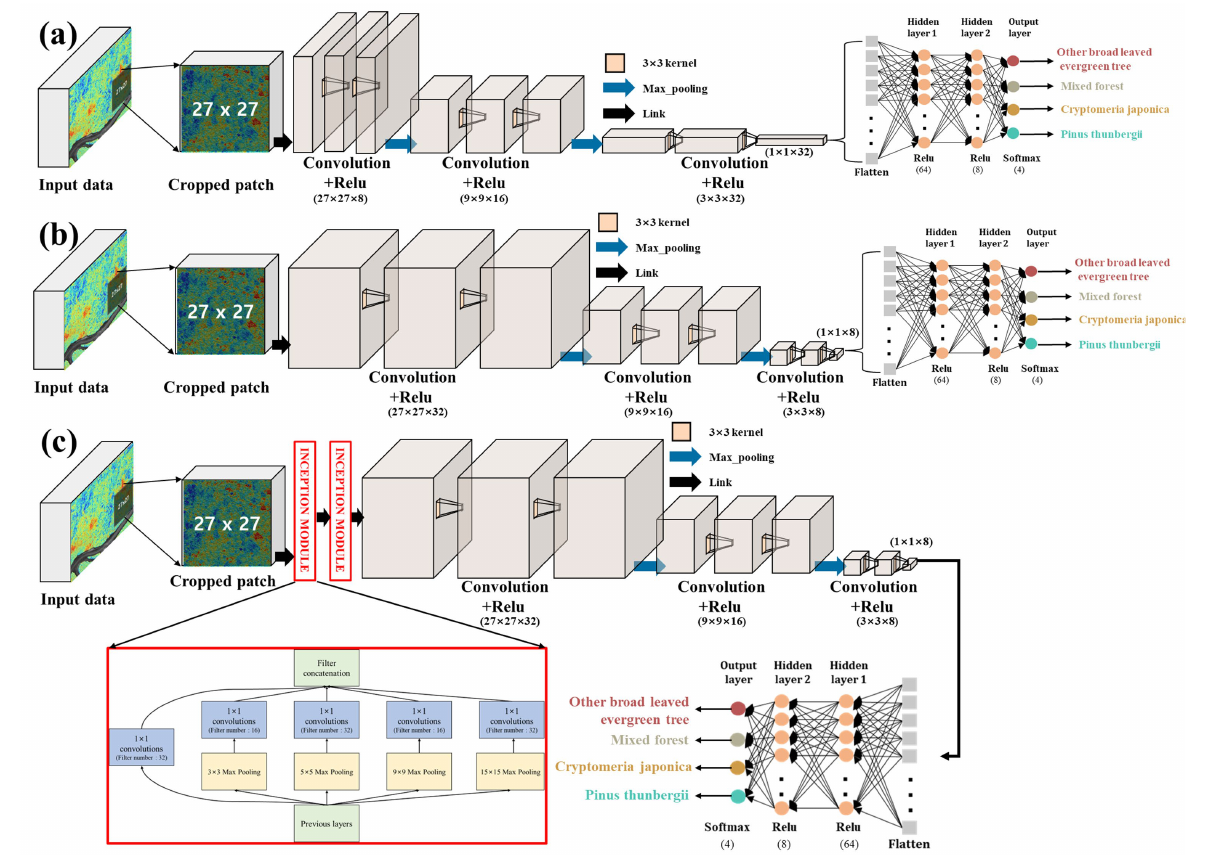
Figure 3. Model architecture proposed in this study: ( a ) CNN-1, ( b ) CNN-2, and ( c ) CNN-3.